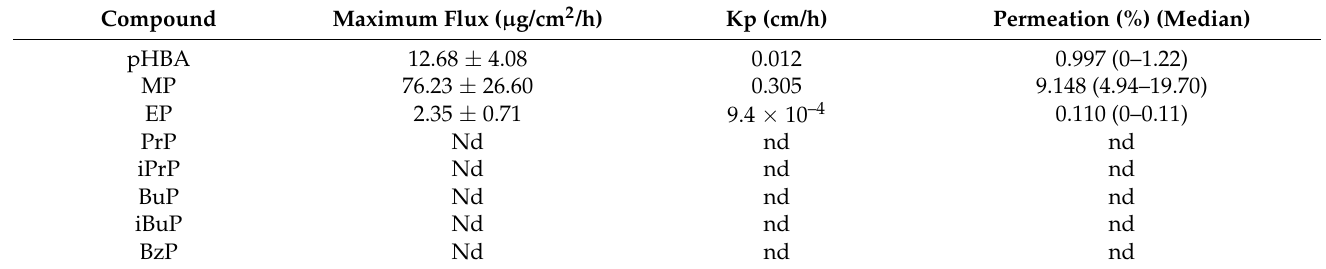
Table 2. Permeability coefficient and maximum flux ± standard deviation of the three compounds able to cross the skin. Median of % permeation, with 95% interval confidence given in